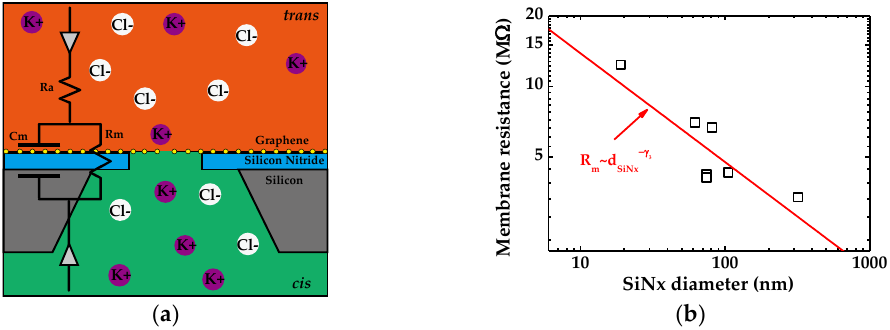
Figure 5. ( a ) Schematic of free-standing monolayer graphene nanopore and equivalent circuit of the system; and ( b ) the membrane resistance as a function of underlying SiN x diameter.